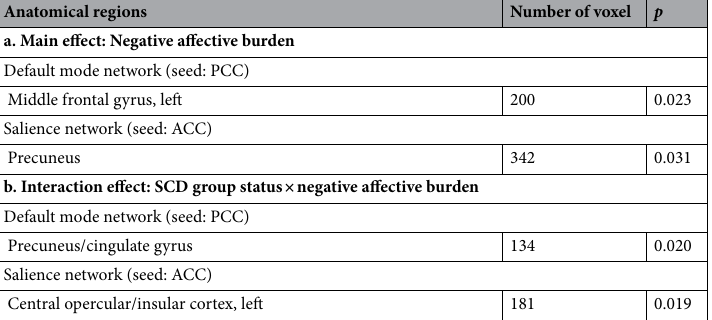
Table 4. Associations between negative affective burden and SCD status on functional connectivity. Results of the seed-to-voxel regression analysis are presented at cluster level for the main effect (A) and interactive effect (B) between negative affective burden and subjective cognitive decline (SCD) status. Statistical parametric maps were thresholded using a height threshold of p < 0.005 (uncorrected) at the voxel level and an extend threshold of p < 0.05 (FDR-corrected) at the cluster level. For each significant cluster, this tables specifies the corresponding anatomical region, the number of voxels (actual cluster size) and the FDR-corrected p value. ACC anterior cingulate cortex, FDR false discovery rate, PCC posterior cingulate